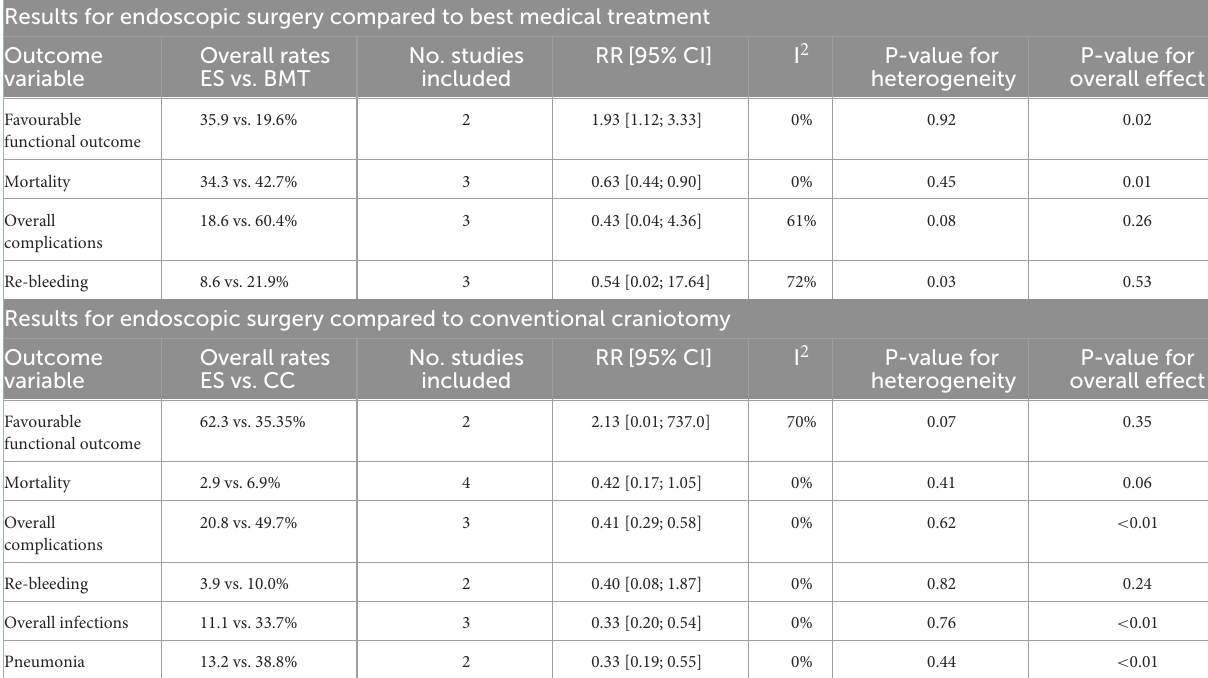
TABLE 2 Results of the meta-analysis for ES compared to BMT and CC. Results for endoscopic surgery compared to best medical treatment Outcome